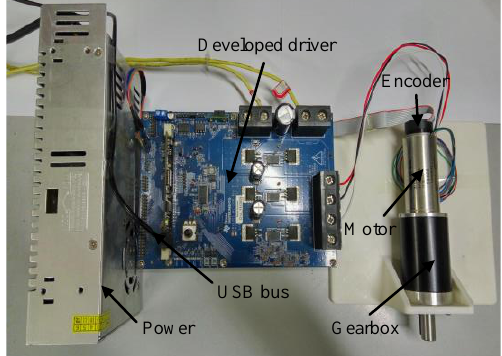
Table 3. Motor and gearbox parameters.